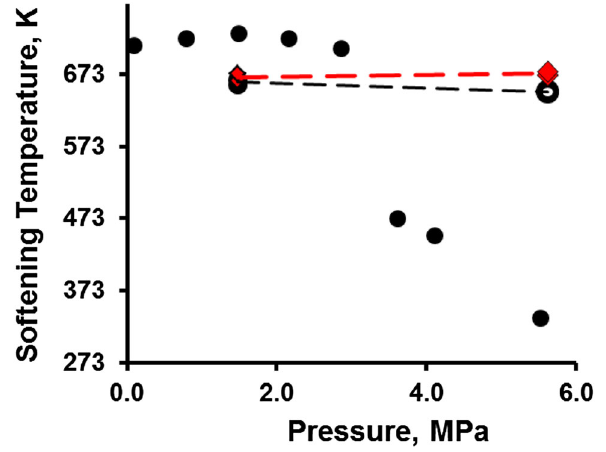
Fig. 4 Effect of CO 2 ( red square ) and helium ( open circle ) on the softening temperature of a Pocahontas coal, compared to Khan’s (Khan and Jenkins 1985) data ( filled circle )